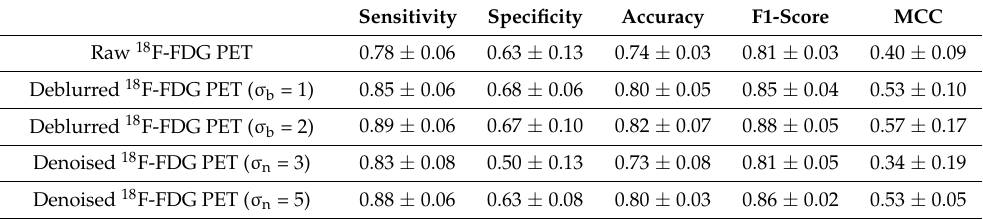
Data are presented as means ± standard deviations over cross-validation folds. Abbreviations: MCC, Matthews Correlation Coefficient; 18 F-FDG PET, 18 F-fluorodeoxyglucose positron emission